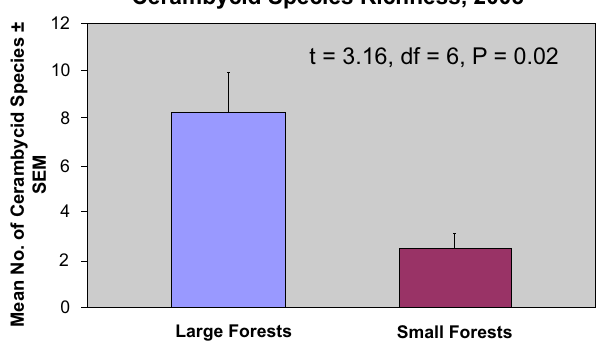
Figure 5. Comparison of Cerambycid species richness between large forests and small Forests. The four large forests were Oak Opening, Secor, Pearson, and Wildwood, and the four small forests were Bradner Preserve, Fuller Preserve, Carter Woods, and